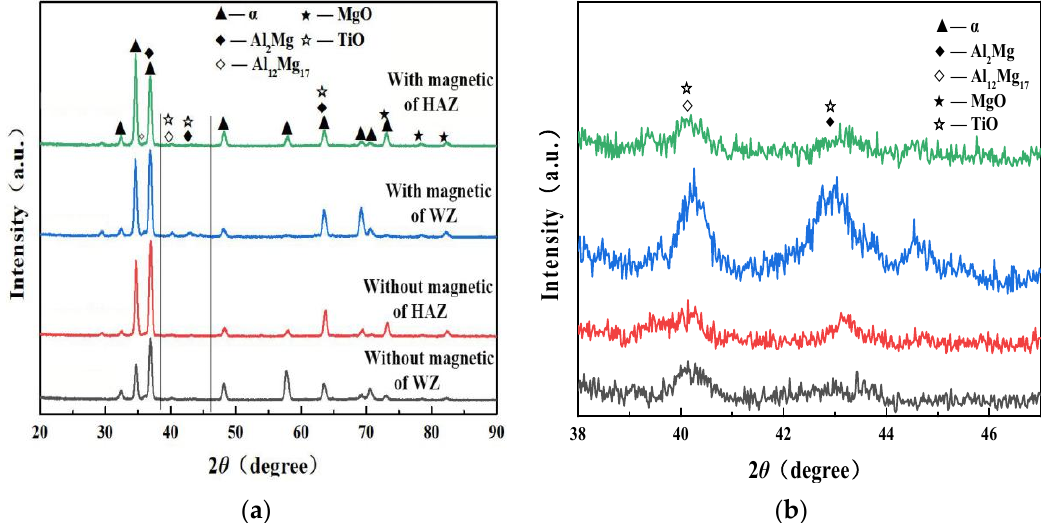
Figure 2. XRD analysis of welded joint metal. ( a ) master atlas; ( b ) local magnification mapping.